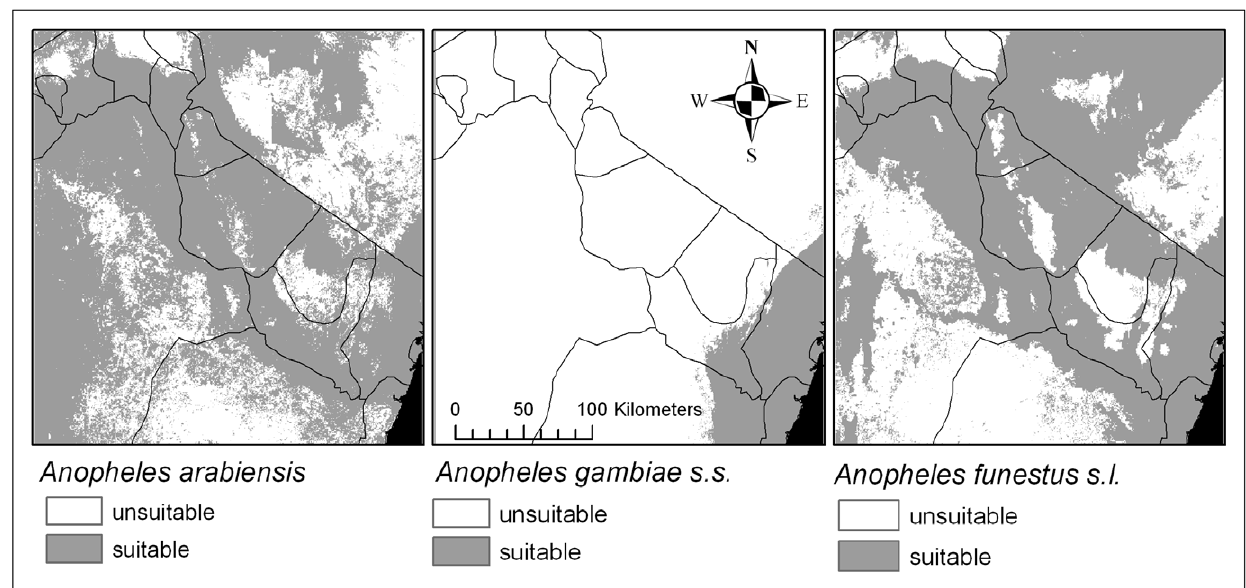
Figure 2. Malaria vector niche models. Models show the area of predicted suitable habitat (shaded area) at a resolution of 30 6 30 metres across north eastern Tanzania for the dominant malaria vector species, An. arabiensis , An. gambiae s.s. and An. funestus